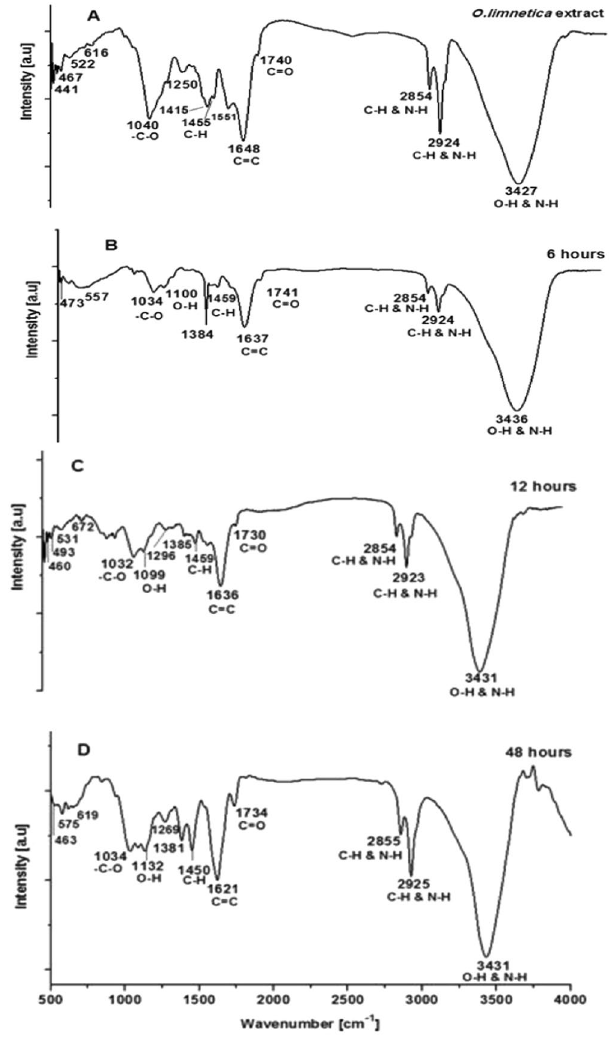
Figure 5. FT-IR spectrum of O. limnetica extract and O-AgNPs at different reaction time (h) [6, 12, and